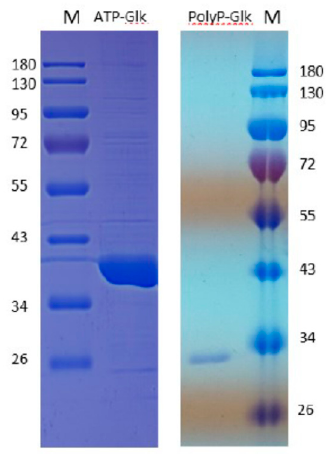
Figure 1. 12% sodium dodecyl sulfate–polyacrylamide gel electrophoresis of 100 µ g recombinant ATP-dependent glucokinase and 20 µ g polyP-dependent glucokinase from Methylomonas sp. 12. M-markers of molecular masses, kDa.